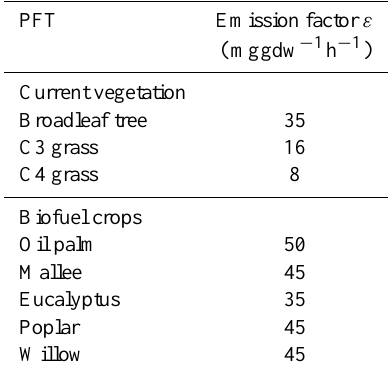
Table A1. Values used to scale isoprene emission factors Table B1. Values used to scale leaf area index and roughness lengths used in the FRSGC/UCI